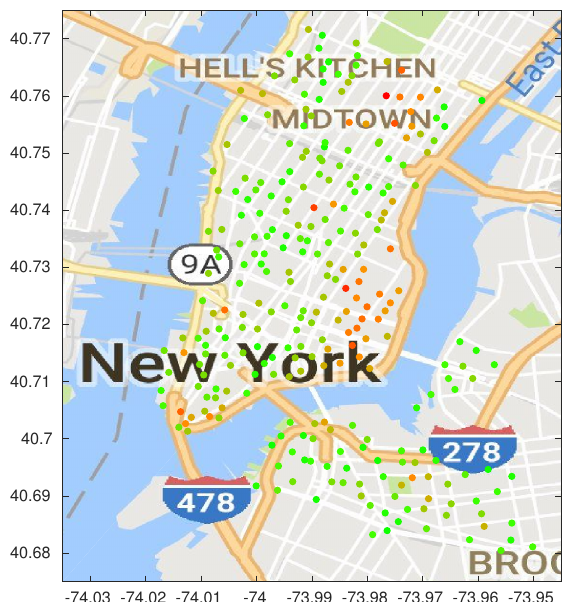
Figure 13. Map of the bike-sharing stations, color-coded from green (zero failure rate) to red (maximum failure